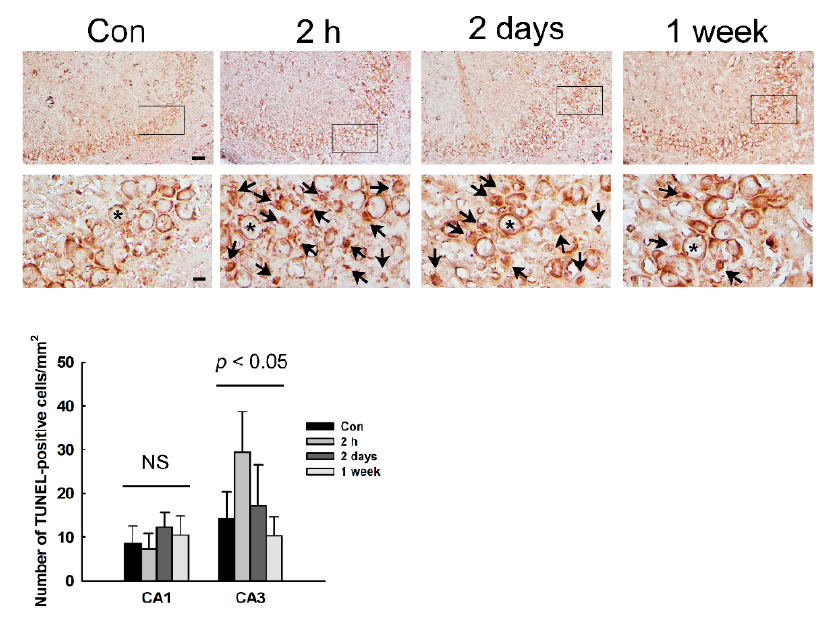
Figure 5. Apoptotic cell death in the hippocampus of NMDA. Apoptotic cell death was detected using terminal, deoxynucleotidyl transferase-mediated, dUTP–biotin, nick end labeling (TUNEL) staining. Arrows and asterisks indicate TUNEL-positive and -negative cells, respectively. Results are expressed as mean number of TUNEL-positive cells ± SD. Scale bars = 50 (low magnification) or 10 µ m (high magnification). NS: not significant.